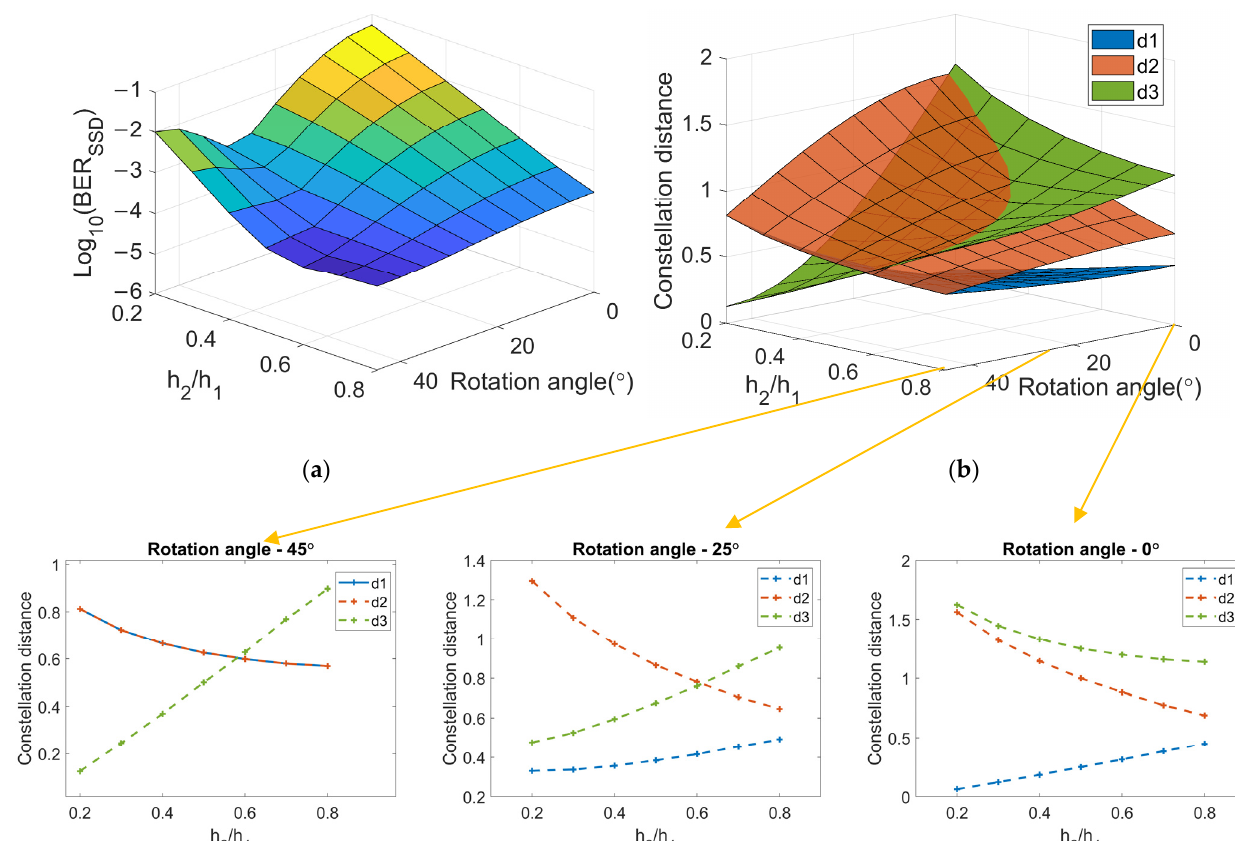
Figure 6. Results of the 2nd channel gain setting. ( a ) BER. ( b ) Constellation distance.